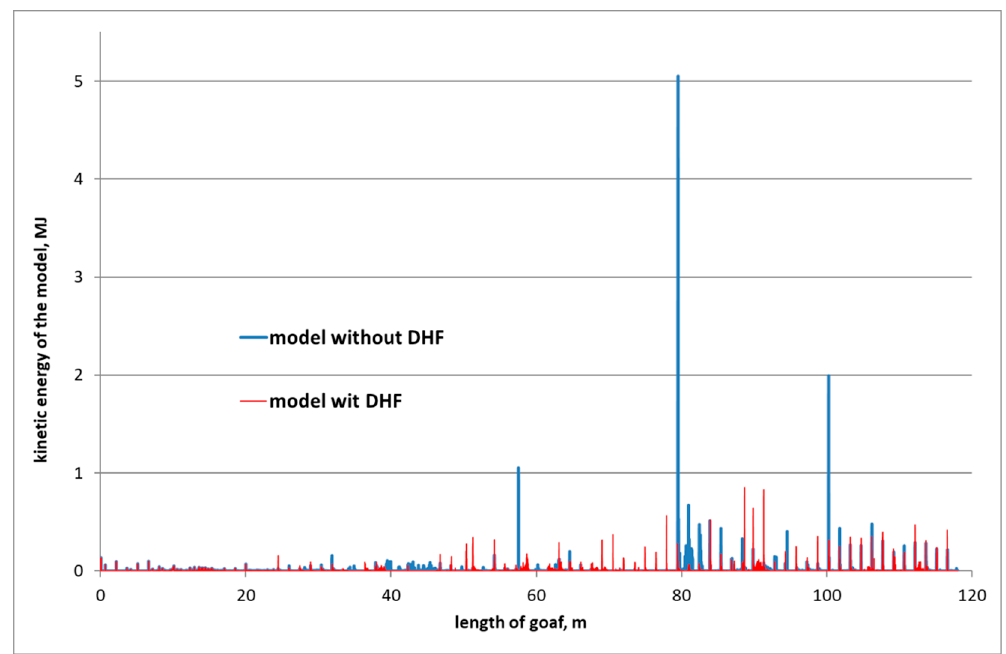
Figure 10. Kinetic energy registered in the modeled rock mass.